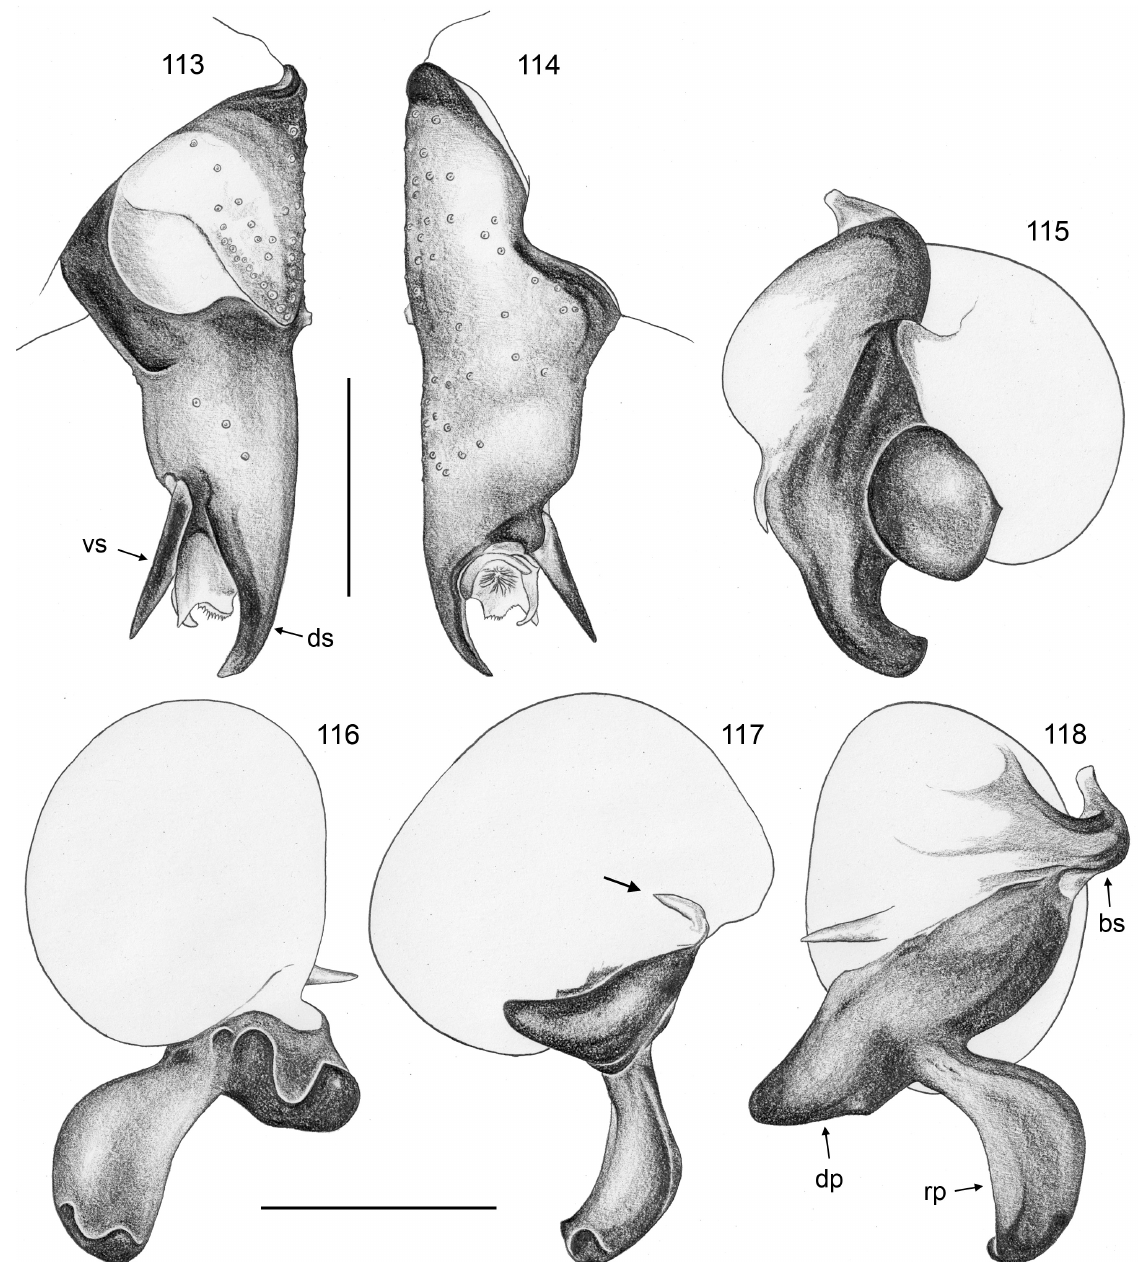
Figs 113–118. Stygopholcus photophilus Senglet, 1971; male from Episkopi, Crete (ZFMK (Ar 22205)). 113–114 . Left tarsus and procursus, prolateral and retrolateral views. 115–118 . Left genital bulb, retrolateral, ventral, prolateral-distal, and dorso-distal views; arrow points at weakly sclerotized process. Abbreviations: bs = basal sclerite; dp = dorsal process; ds = dorsal sclerite; rp = retrolateral process; vs = ventral sclerite. Scale bars: 0.5